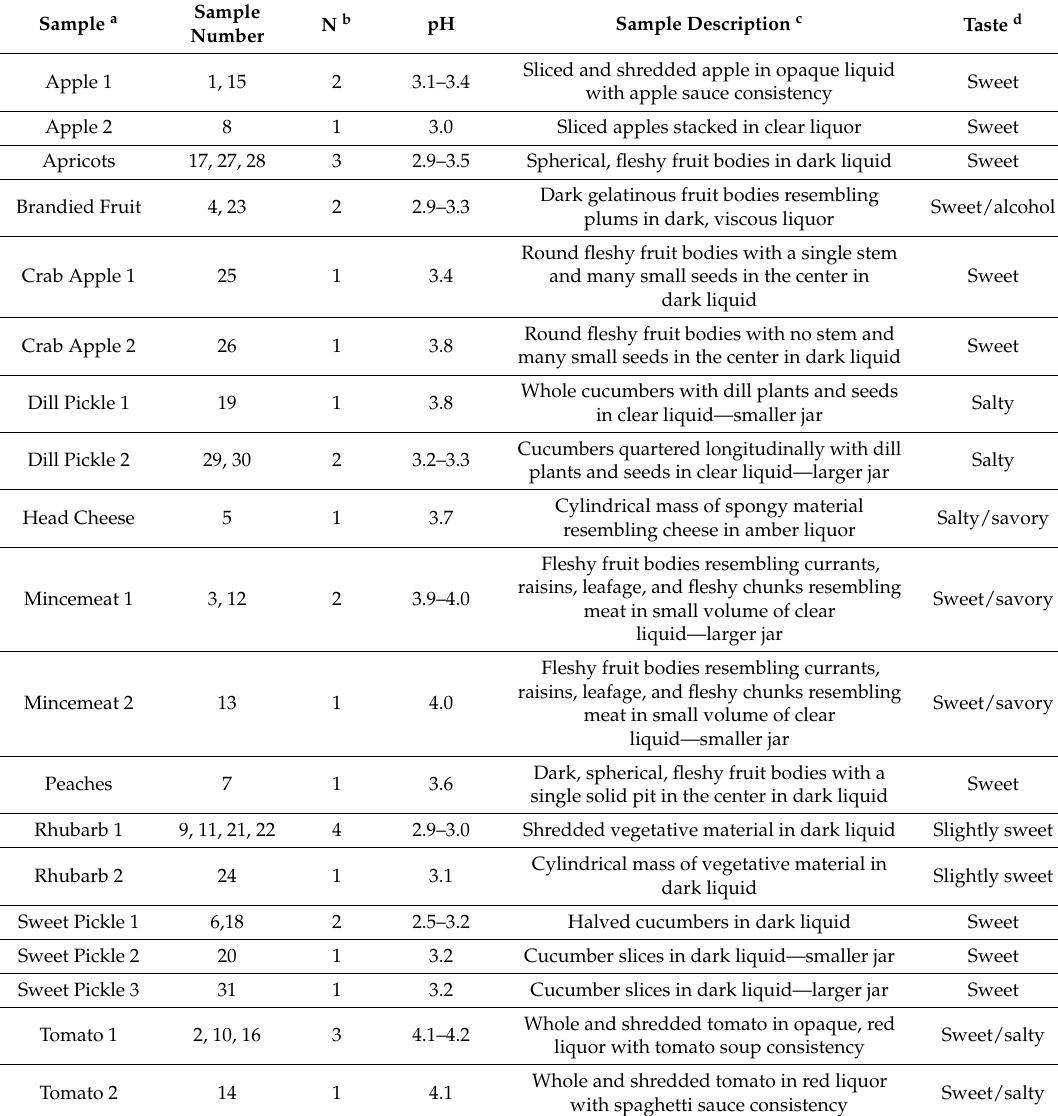
Table 1. Quantitative and qualitative data for the preserved foods assessed in this